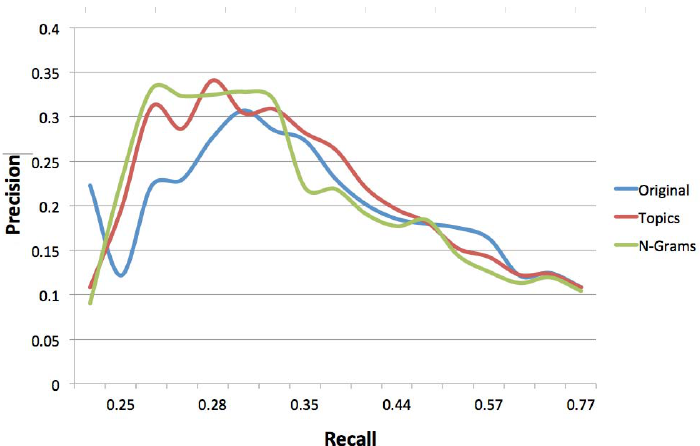
Figure 3. Precision-recall curve at different concept weight